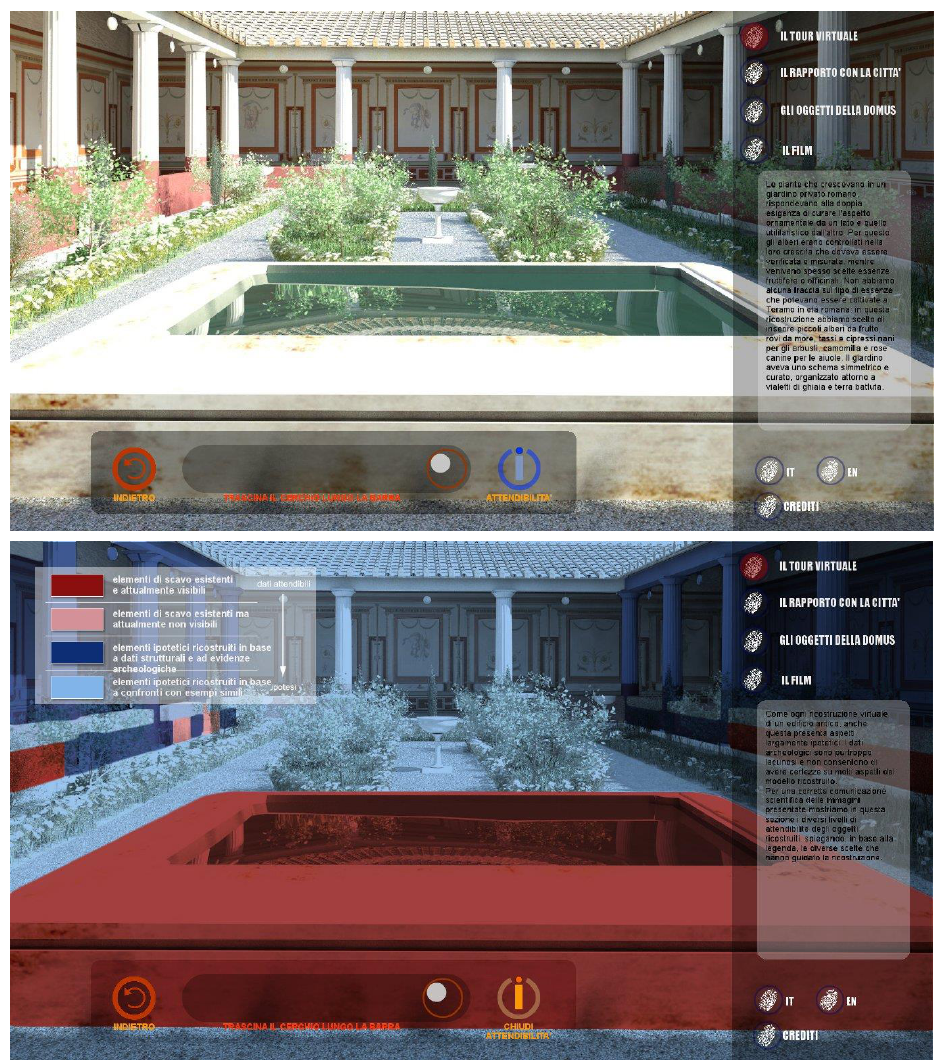
Figure 13. Virtual reconstruction of Domus S. Anna in Teramo. Above the 3D model of the reconstructed peristylium . Below the codification through colors of the different levels of reliability, on the basis of the available interpretative sources. Realized by CNR ITABC, 2011, Archaeological Museum in Teramo.